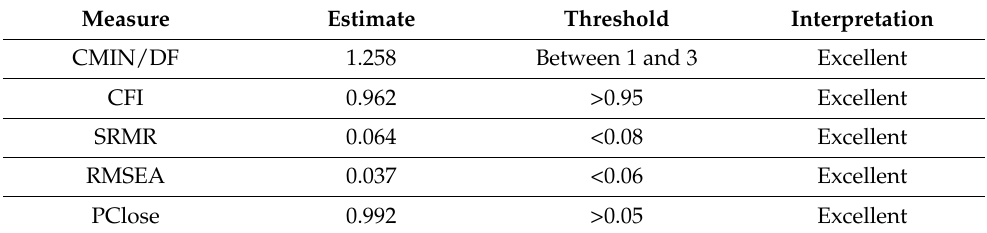
Table 5. Model fit indices.